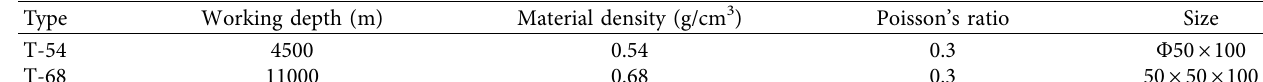
Figure 1: Two types of buoyancy materials. Table 1: Parameters of buoyancy materials.